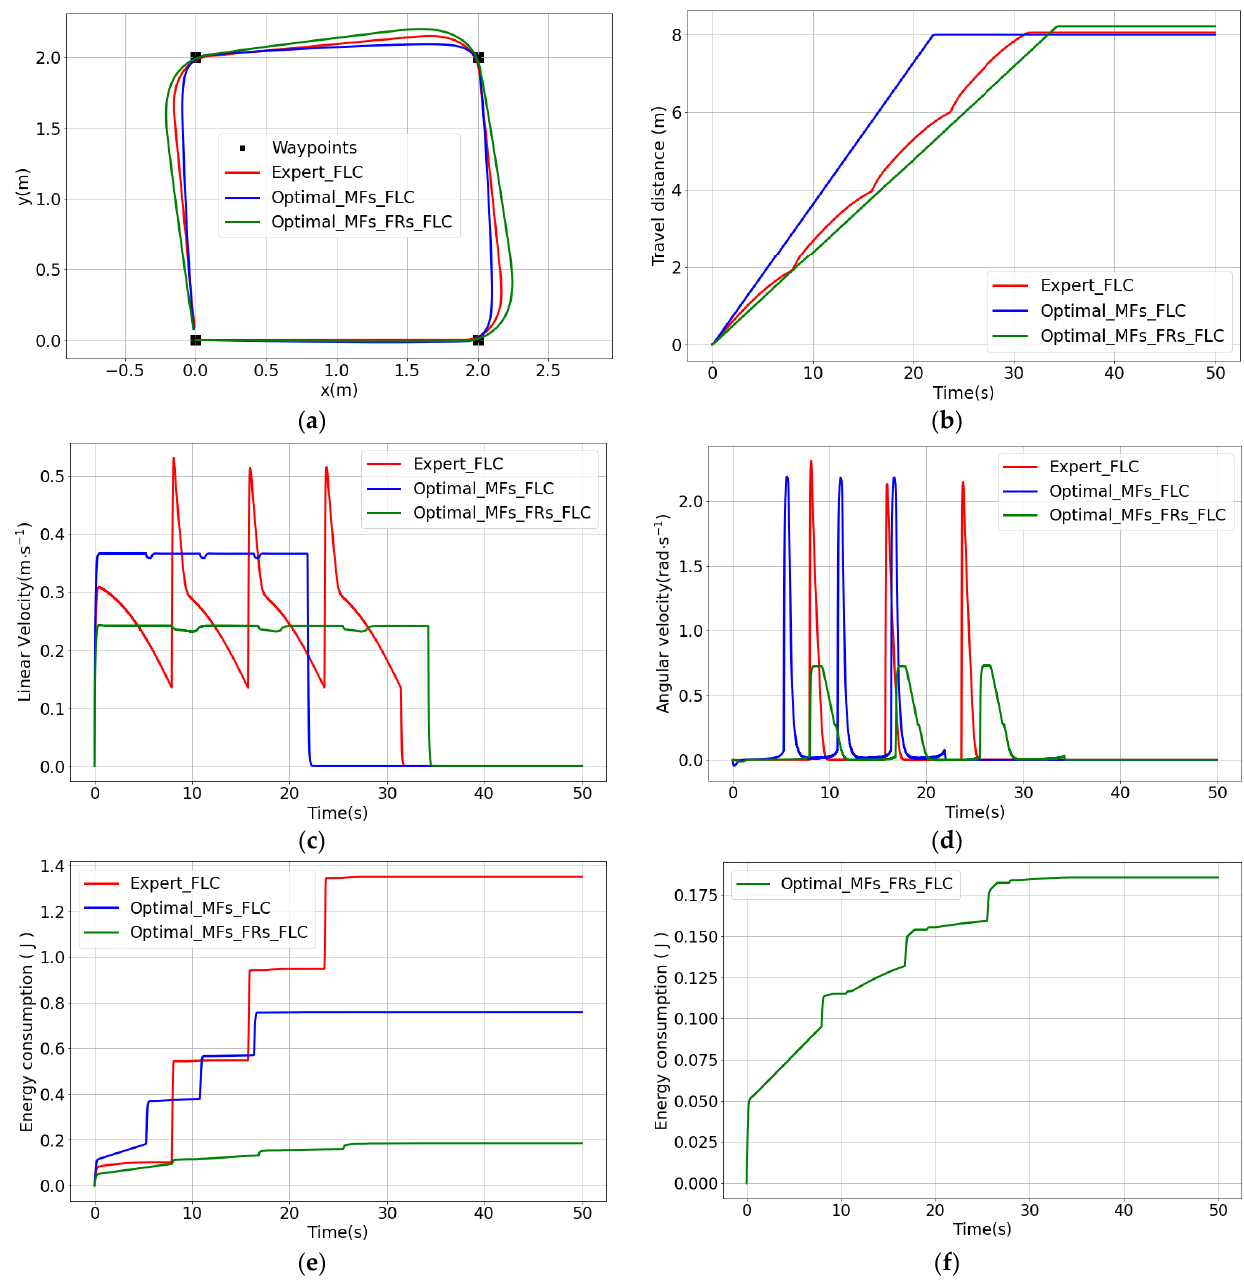
Figure 16. The simulation results in the case of using the square path. ( a ) The trajectory of the robot; ( b ) The robot’s travel distance over time; ( c ) The robot’s linear velocity over time; ( d ) The robot’s angular velocity over time; ( e ) The robot’s kinetic energy loss over time; and ( f ) The zoom of the robot’s kinetic energy loss over time. Table 16. The kinetic energy loss and the travel distance of the robot when the robot tracks the sharp turn path by the different controllers.